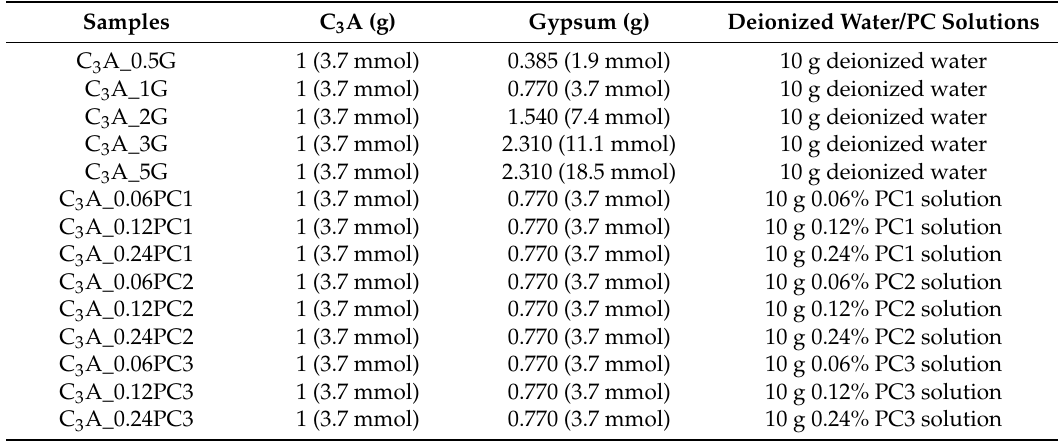
Table 3. Summary of the C 3 A-gypsum